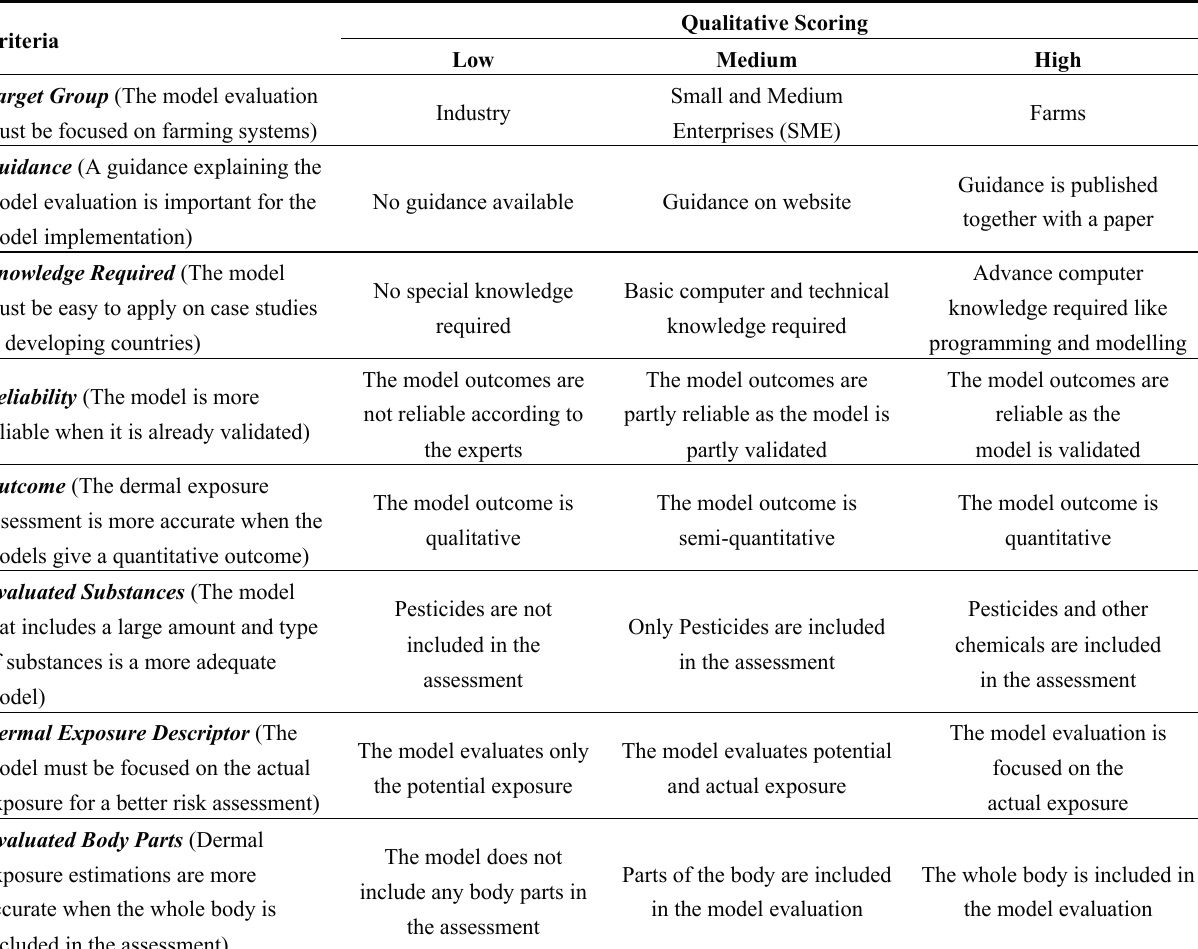
Table 1. Description of the qualitative scoring system for the multi-criteria